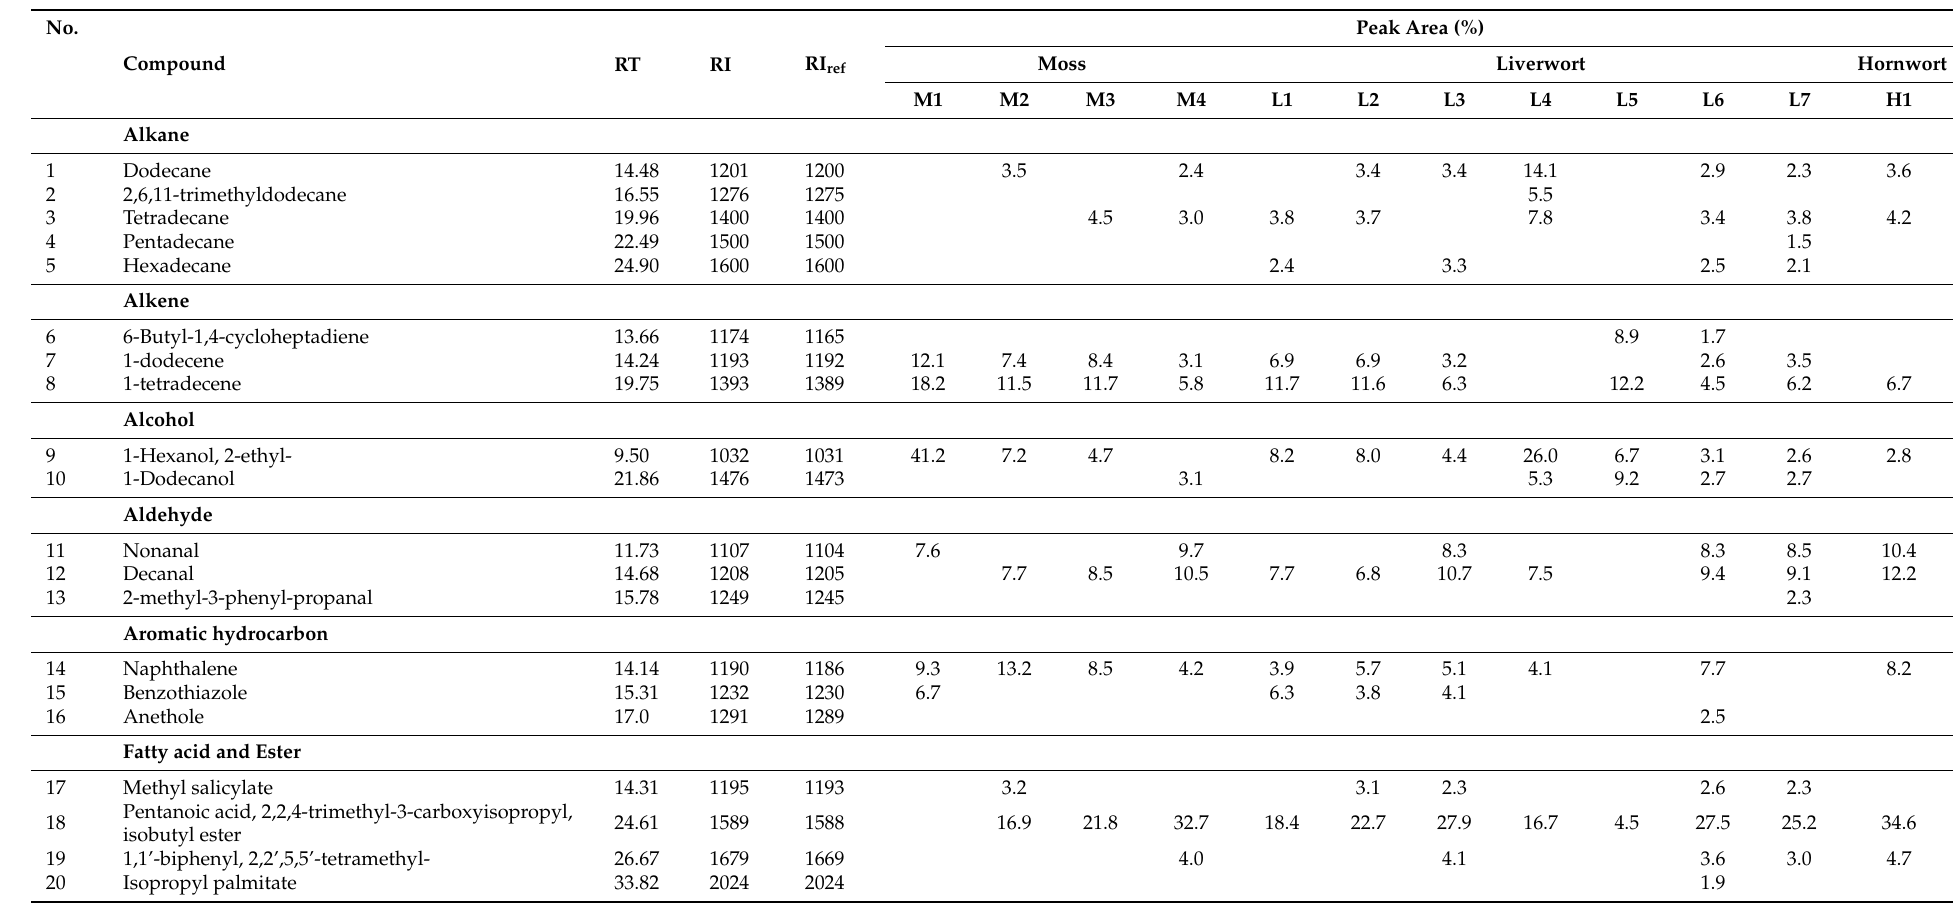
Table 2. Major volatile compounds identified in bryophyte headspace from Cameron Highlands. RT: retention time; RI: retention index; RI ref : retention index